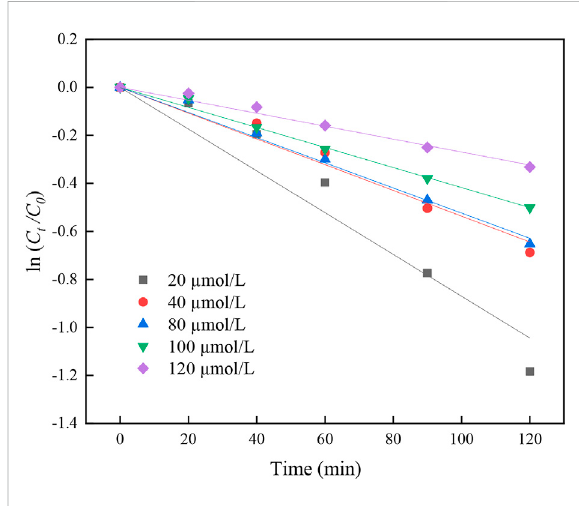
FIGURE 3 Effect of initial concentration on photodegradation of acid orange 8 by NCM.